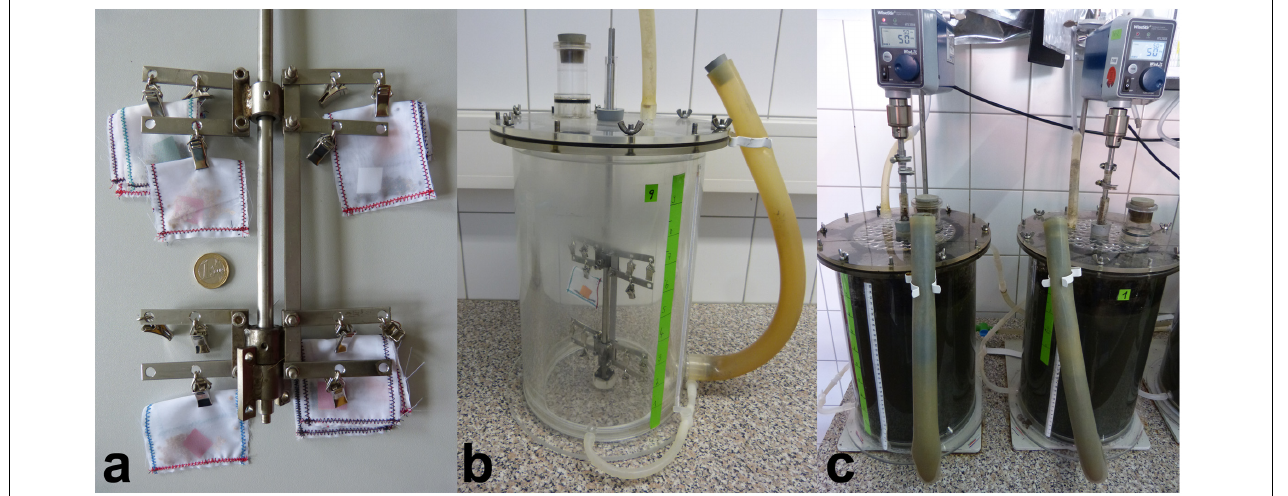
FIGURE 1 | Experimental setup for anaerobic digestion of seeds in lab-scale reactors. (a) Central paddle stirrer with attached fine mesh polyester bags enclosing seeds and identification markers. (b) Lab-scale reactor consisting of a double-walled cylinder for temperature control via a water jacket, a gas-tight lid with tubes for feeding, gas collection, and attachment of the stirrer, and a separate outlet for the digestate at the bottom. (c) Running reactors connected to thermostat, stirrer drive, gas meter and gas analyzer.